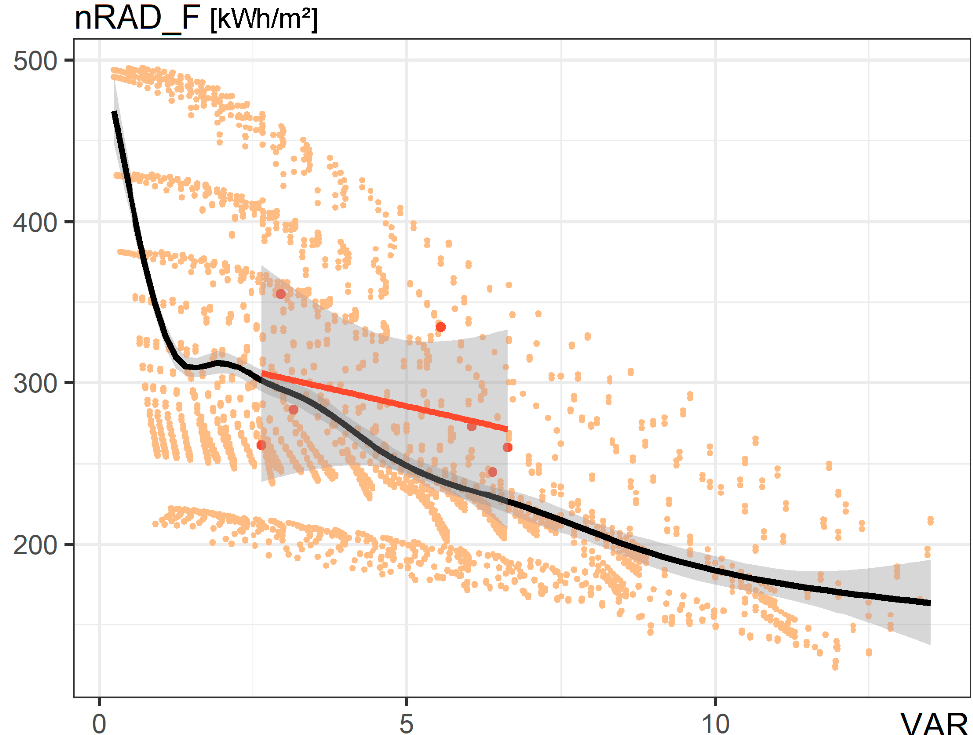
Figure 21. Non-linear regression function of density metric VAR and normalised EC-metric (black line) with case-study-fitted linear regression line (red) and 95% CI in grey. The graph indicates a low correlation with the scattering and clustering of data points.